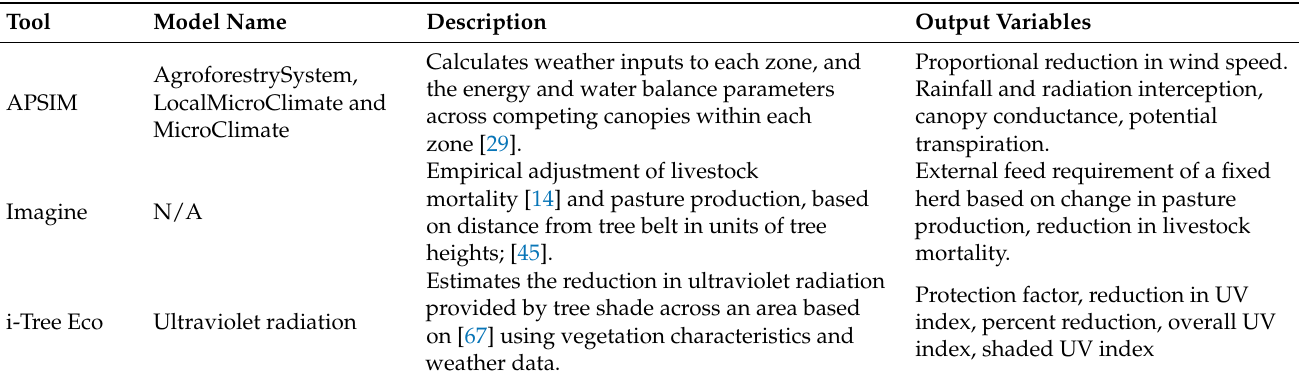
Table 4. Summary of the shortlisted tools and associated models that quantify wind, shelter, and